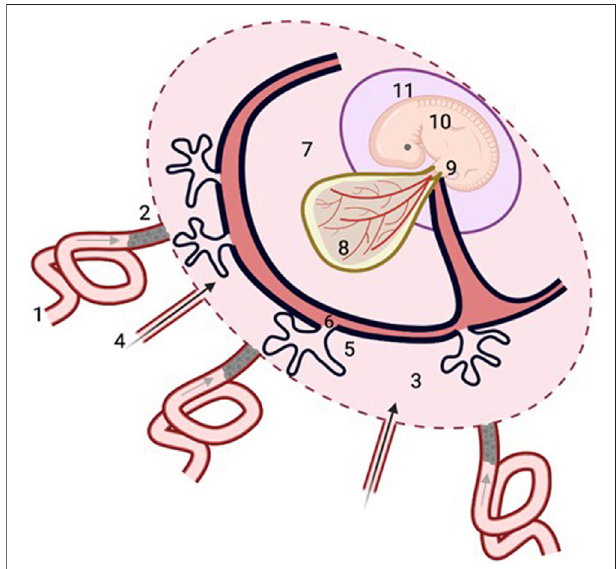
FIGURE 2 | Histiotrophic pathway for embryonic nutrient delivery. Maternal plasma ultra fi ltrates containing nutrients from the spiral arteries (1, grey arrow) percolate through plugs of endovascular trophoblast cells that occlude their openings (2), toreach the intervillous space of the placenta (3),alongwithsecretionsfromtheuterineglands(4,blackarrow).Nutrientsare taken up by the syncytiotrophoblast of the developing placenta (5), and pass throughthevillousmesenchymalcore(6)withconnectionstotheexocoelomic cavity (7) containing coelomic fl uid with relatively high concentrations of methionine, folate and vitamin B 12 ( Table 1 ) which bathes the yolk sac (8). Nutrients taken up by the yolk sac from the coelomic fl uid enter the vitelline circulation of the yolk sac (8) that is in direct continuity with the embryonic circulation, or else pass from theyolk sac cavity along the direct connectionof the vitelline duct to the embryonic gut (9) of the embryo (10), which is contained within the amniotic cavity (11). Figure was created with